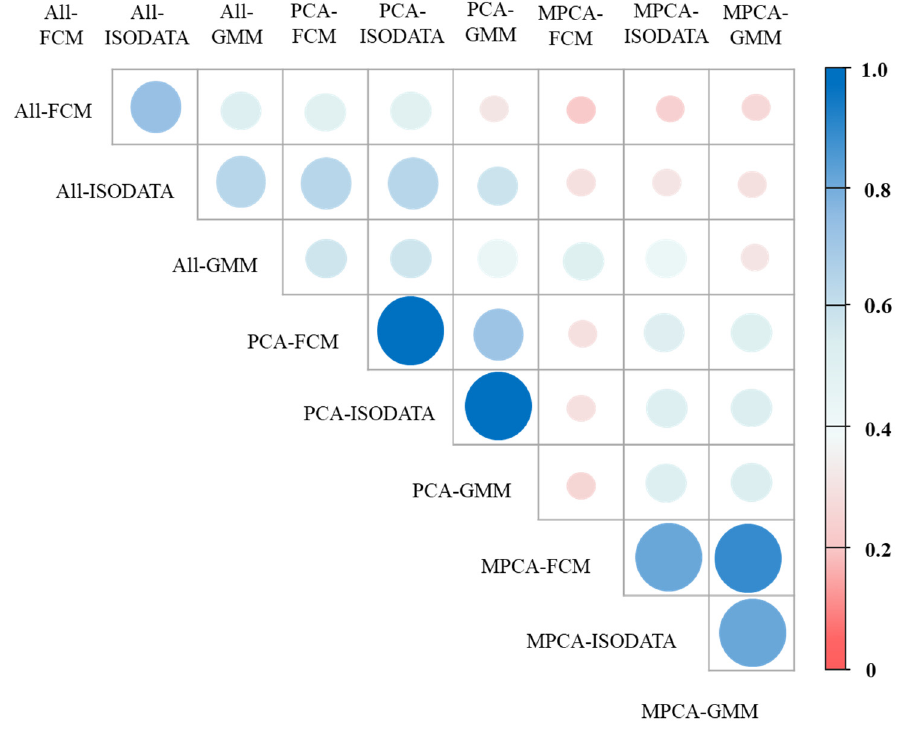
Figure 6. Kappa degrees of agreement between maps obtained by nine clustering models.